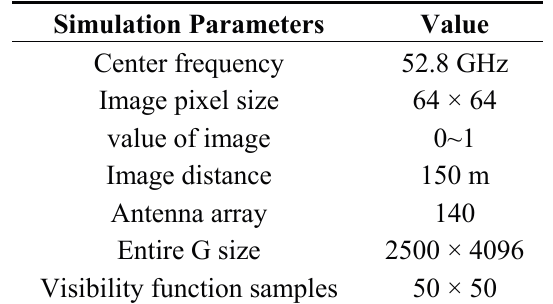
Figure 2. Target brightness temperature distribution of a tank and car. Table 2. The main simulation parameters of SAIR.